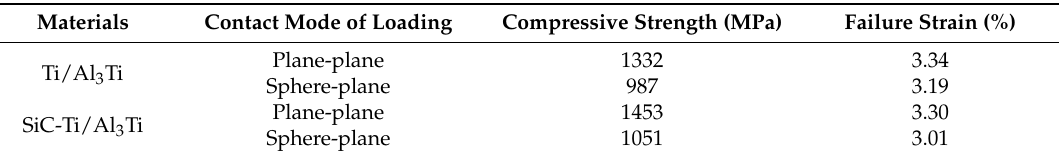
Table 4. Compressive properties of Ti-(SiC f /Al 3 Ti) CCFR-MIL and Ti/Al 3 Ti MIL composite under different loading conditions.